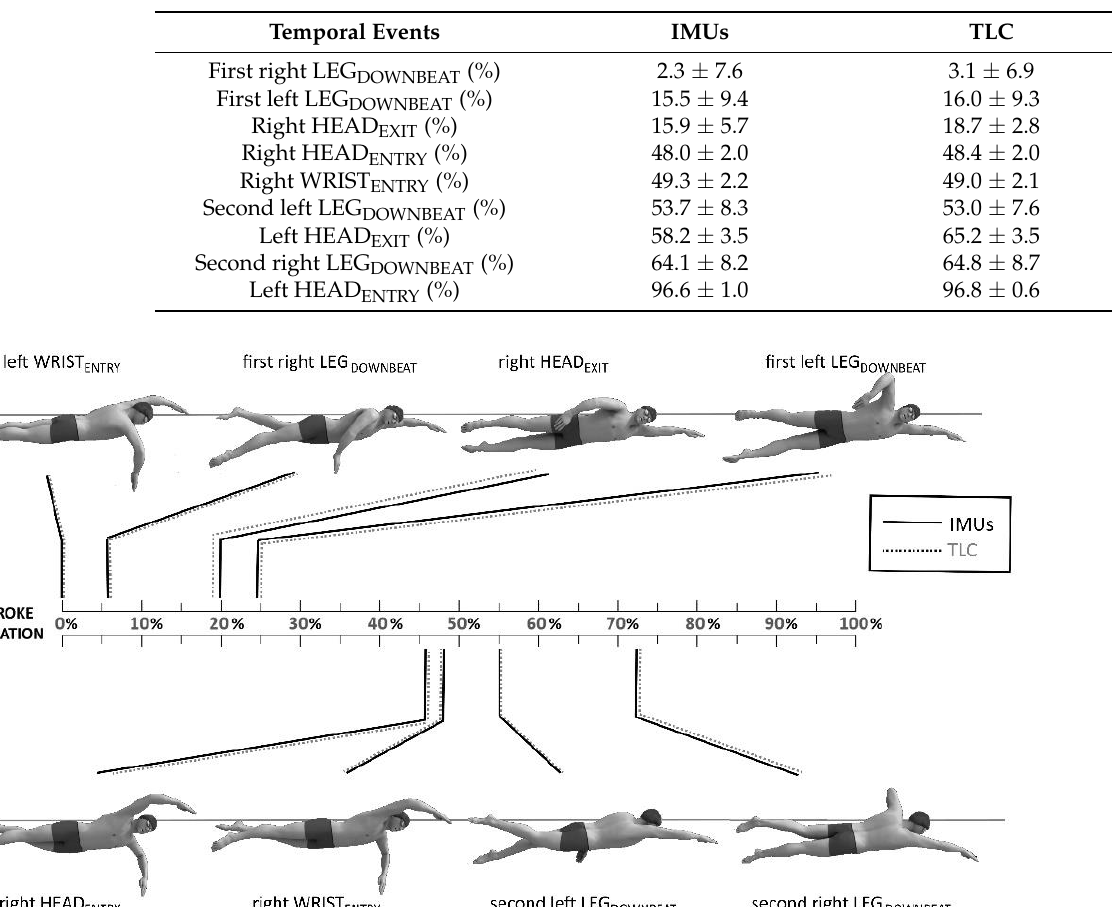
Table 1. Mean ± SD timing of the analyzed temporal events in percentage of the stroke duration when comparing measurements with IMUs and video-based technique (TLC). The stroke duration was normalized to left WRIST ENTRY events.